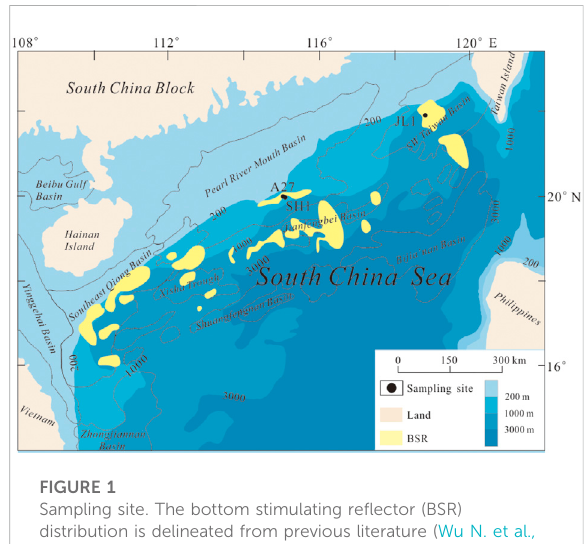
FIGURE 1 Sampling site. The bottom stimulating re fl ector (BSR) distribution is delineated from previous literature (Wu N. et al.,